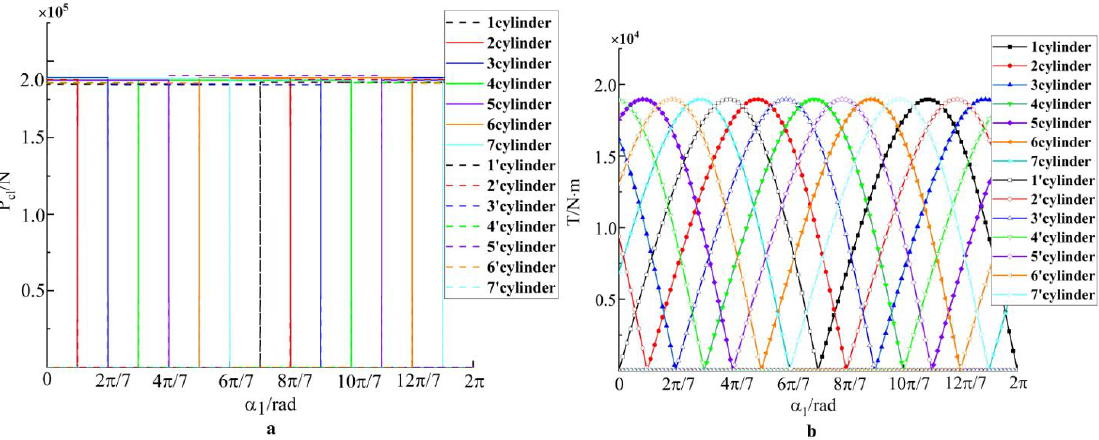
Figure 12. ( a ) Diagram of the rod force changing with the first angle, ( b ) Diagram of the torque changing with the first angle.